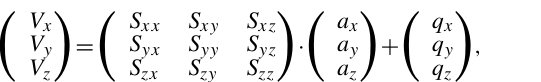
Figure 3. Piezo-electric accelerometer: comparison between meth- ods (main sensitivity along the x axis, S xx ).